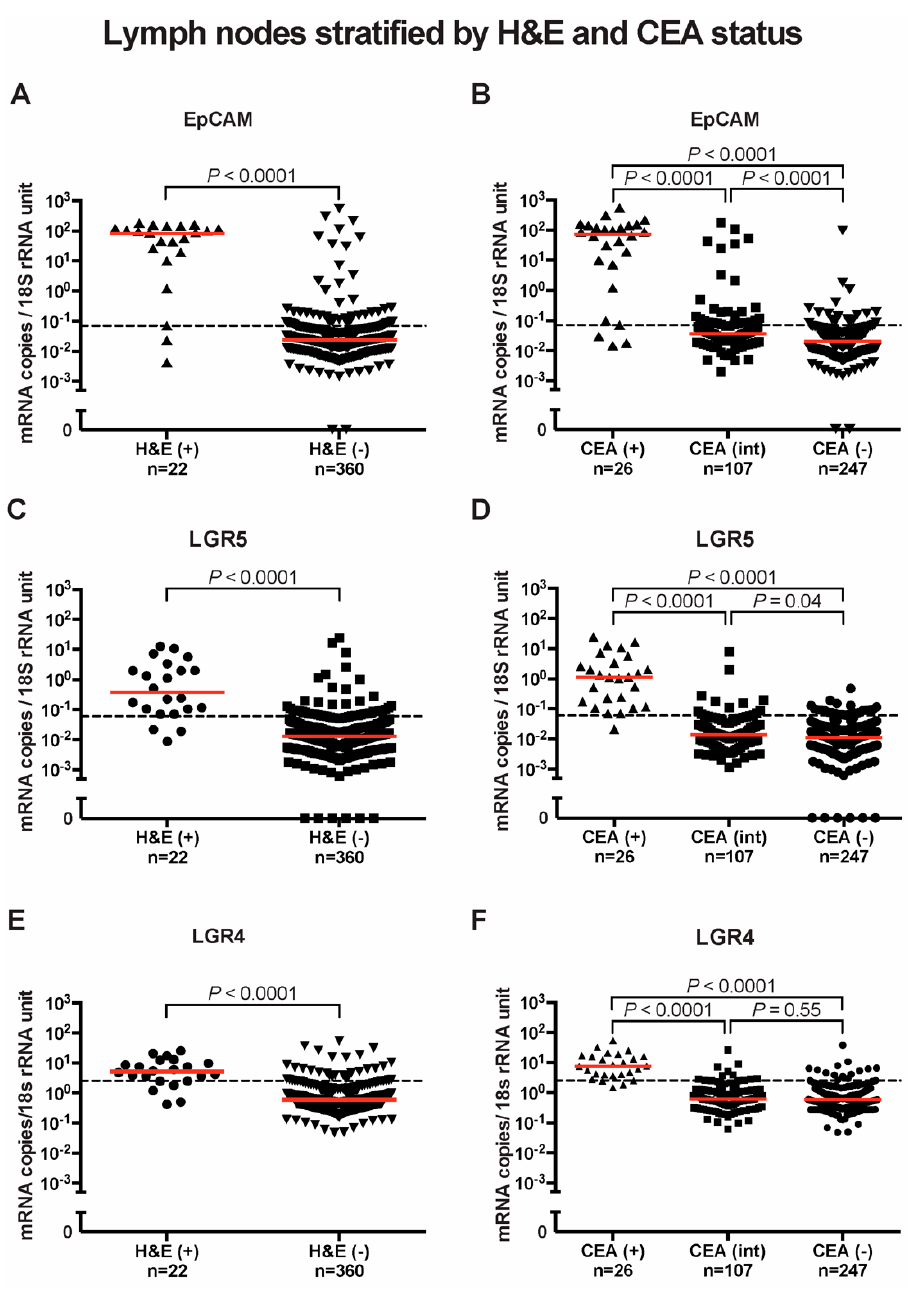
Figure 2. EpCAM, LGR5 and LGR4 mRNA expression in lymph nodes stratified by H&E and CEA status. ( A ) EpCAM, ( C ) LGR5, and ( E ) LGR4 mRNA levels in nonmetastatic (H&E(-)) and metastatic (H&E(+)) lymph nodes. In ( B , D , F ), lymph nodes were divided into three groups according to their CEA mRNA levels; CEA(-) = CEA mRNA levels < 0.013 copies/18S rRNA unit, CEA(int) = intermediate CEA mRNA levels, that is 0.013-3.67 copies/18S rRNA unit, and CEA(+) = CEA mRNA levels > 3.67 copies/18S rRNA unit. Red horizontal lines indicate median values. Dashed horizontal lines indicate clinical cutoff values of 0.07, 0.06 and 2.558 mRNA copies/18S rRNA unit for EpCAM, LGR5 and LGR4 respectively. n = number of lymph nodes. p -values were calculated by two-tailed Mann-Whitney test for comparison between expression levels in ( A , C , E ) and by Kruskal-Wallis nonparametric ANOVA followed by post hoc Dunn’s test for multiple comparisons in ( B , D , F ).